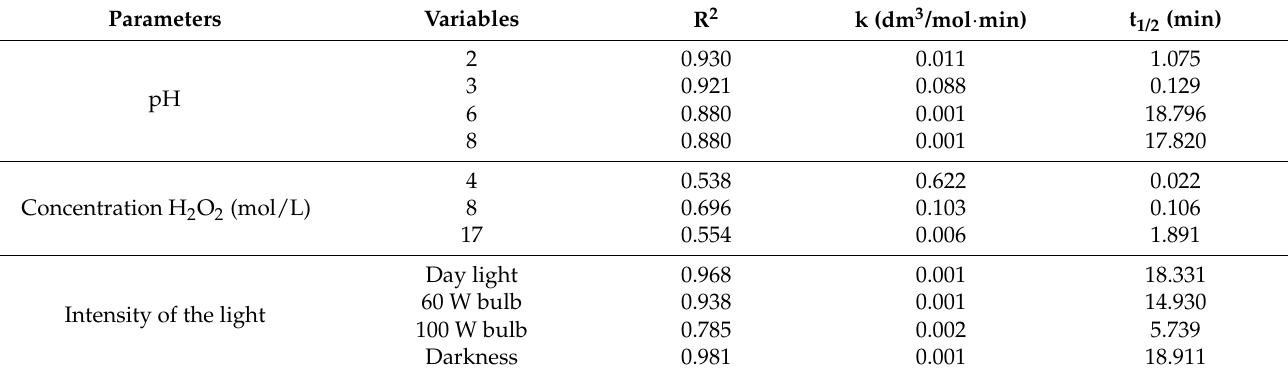
Figure 10. Linear regression plots of the second-order kinetics of indigo carmine degradation reactions under the influence of pH ( a ), light intensity ( b ) and H 2 O 2 concentration ( c ). Table 2. Second-order rate constants for indigo carmine degradation .